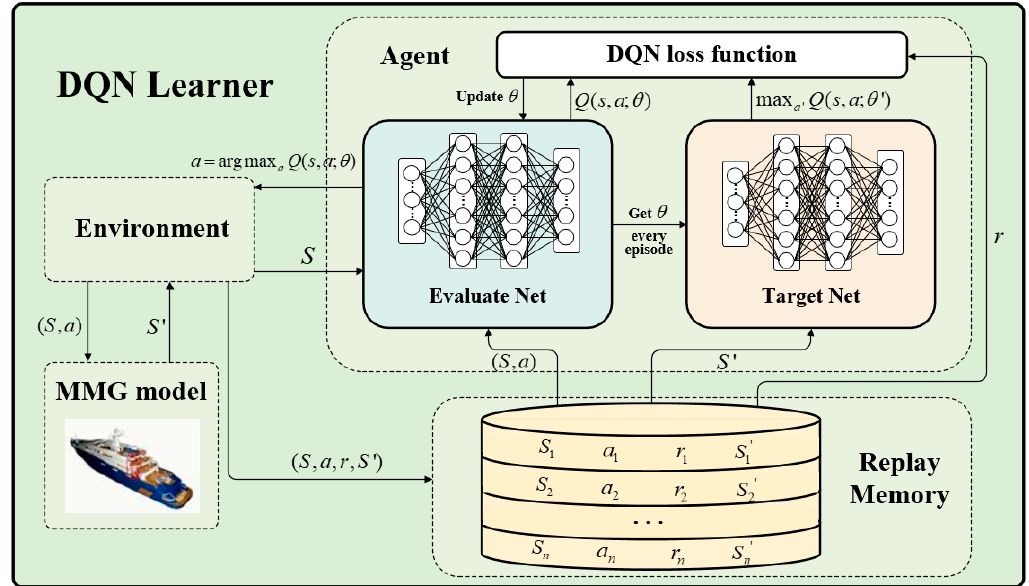
Figure 7. Schematic of the collision avoidance algorithm based on the DQN.